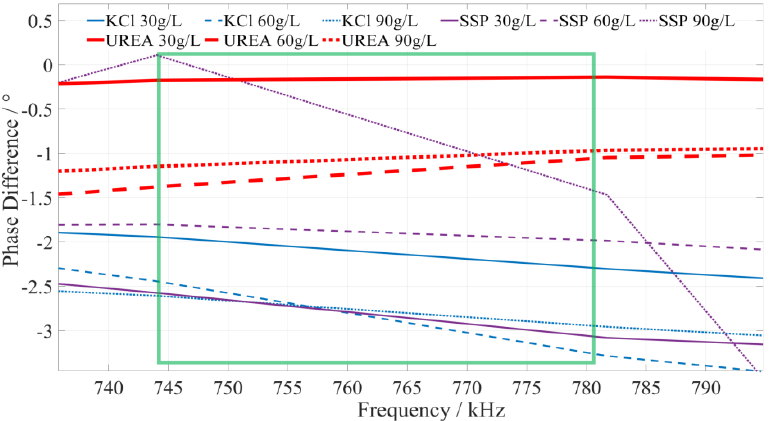
Figure 8. The phase – frequency characteristic curve of urea, potassium chloride, and superphos- Figure 8. The phase–frequency characteristic curve of urea, potassium chloride, and superphosphate phate fertilizer solutions under the excitation signal of 745~780 kHz. fertilizer solutions under the excitation signal of 745~780